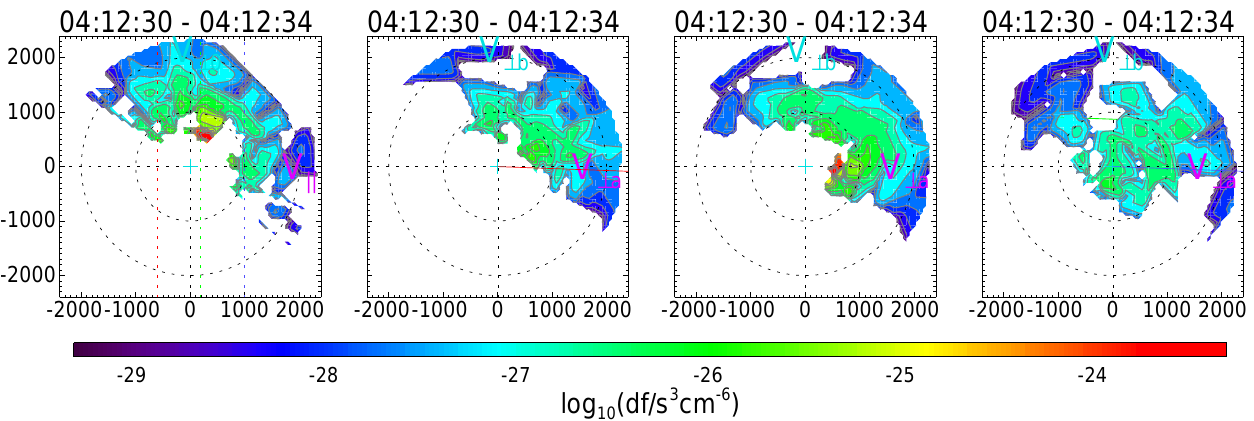
Fig. 5. Fig. 5. 2 April 2002 04:11–04:14UT, ion distributions from HIA in the spacecraft frame. Left panel shows v k × v ⊥ , while the three panels to the right show slices perpendicular to B at values of v k = 0 , ± 800kms − 1 relative to the parallel plasma velocity.